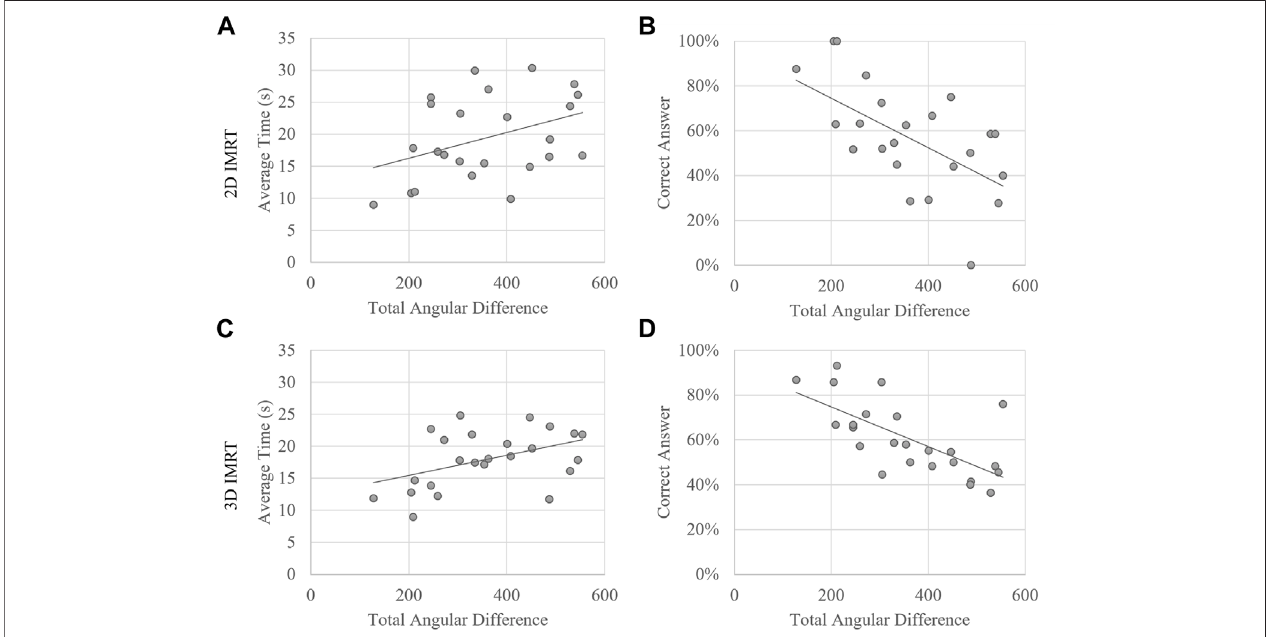
FIGURE 7 | The total angular difference was calculated as the net absolute value of the smallest angular difference between each reference object and the standard. (A,C) The average time per question increased as the total angular difference increased. (B,D) The accuracy with which participants answered questions decreased as the total angular difference